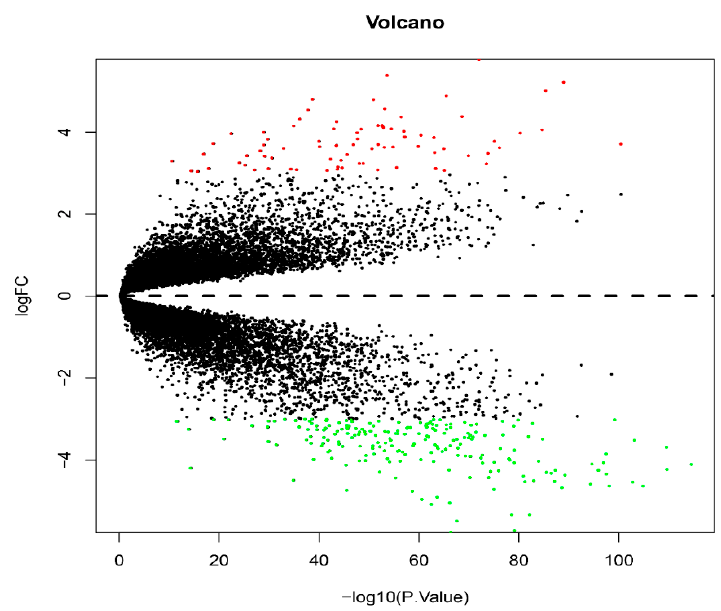
Figure 1. The Volcano plot of differential genes. 210 down-regulated genes and 80 up-regulated differential genes were screened out (|log2FC| > 3, p < 0.05).